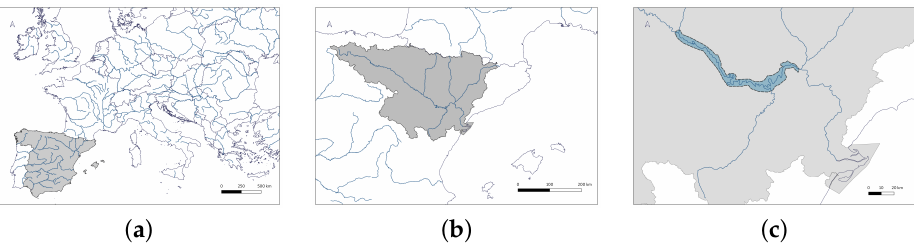
Figure 1. Location of Spain in Europe ( a ); location of the Ebro River basin in Spain ( b ) and location of the computational domain of the study in the basin ( c